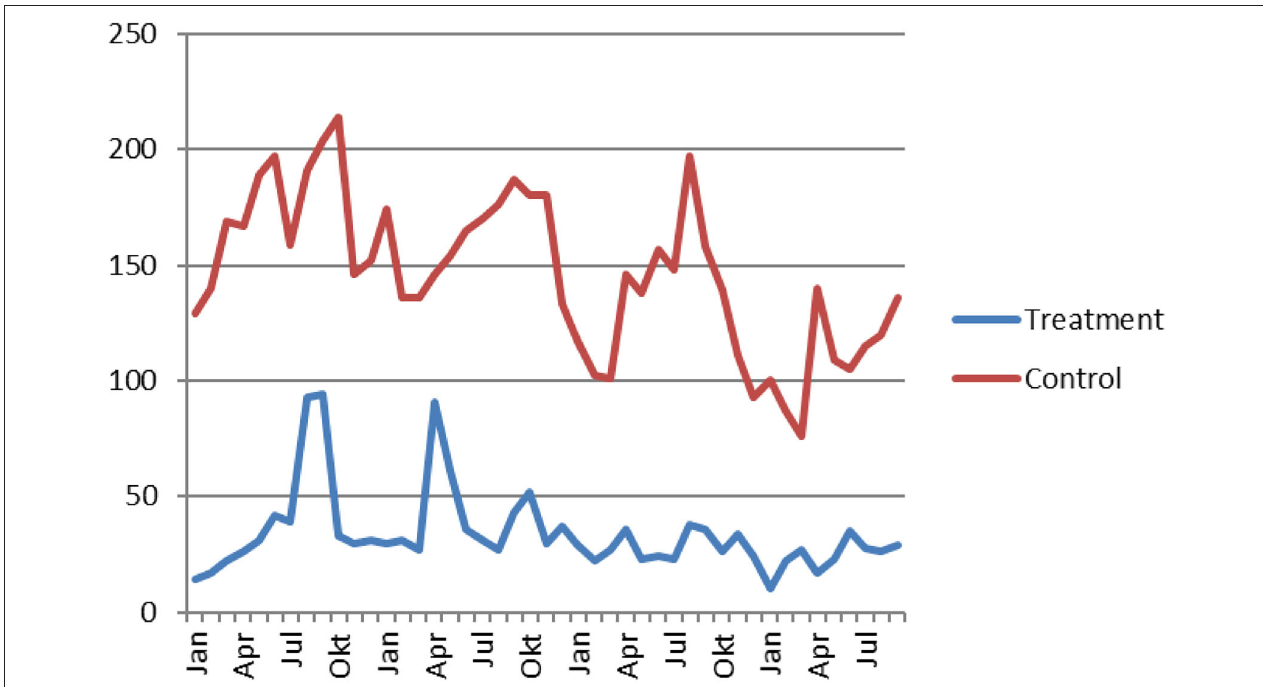
FIGURE 4 | Monthly count of vehicle arson reports. Treatment areas in blue, control areas in red.